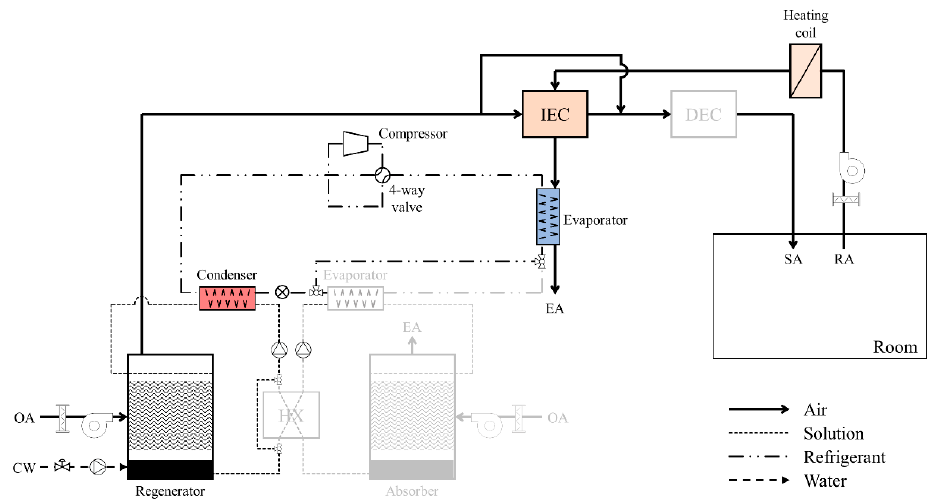
Figure 2. Schematic of the modified LD-IDECOAS in the heating season. CW: city water.